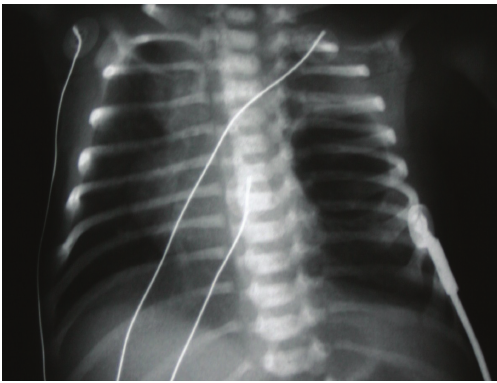
Figure 4: Roentgen imaging of the lungs after